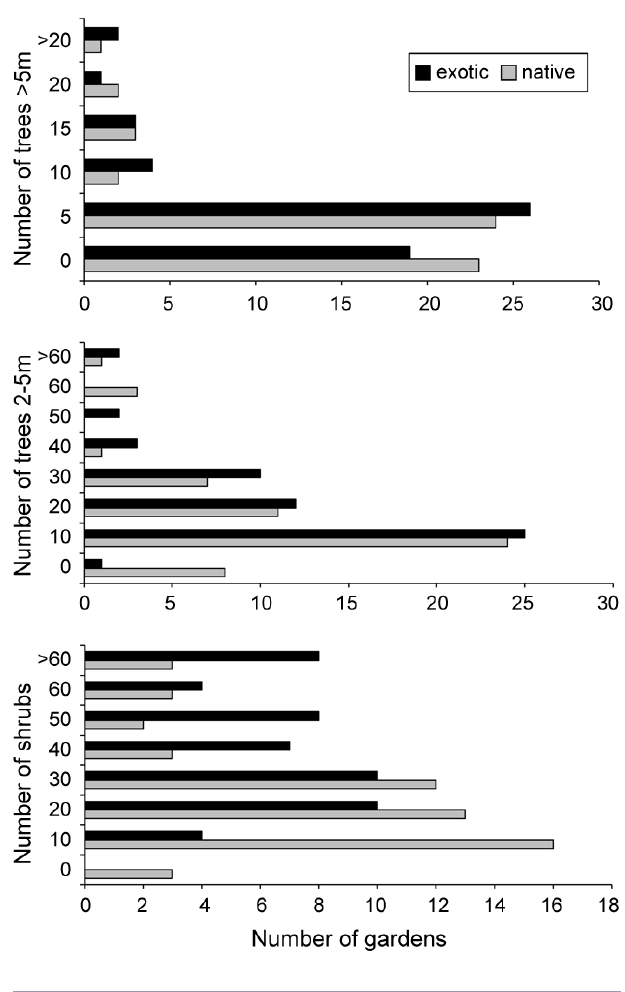
Fig. 3 . Distribution of different height classes of woody vegetation across 55 gardens.